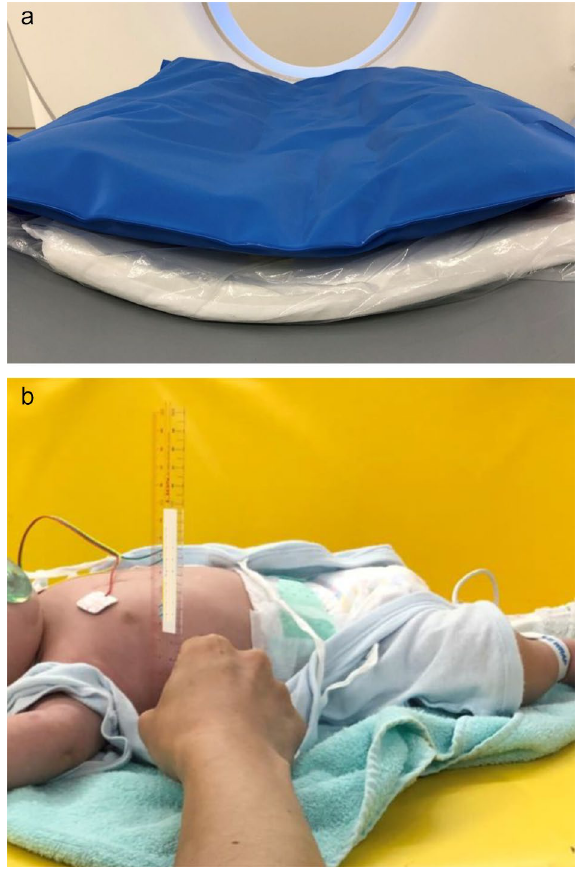
Figure 1. ( a ) The high-resilience pad (white mattress) is put under the vacuum device (blue mat). The total thickness of the pad system was measured at 75 mm from the top plate, which is restricted to move up to 100 mm below the isocenter of the gantry. ( b ) The chest thickness in the supine position was measured at the level of the nipple by a ruler. In the calculated group, the setting table height was calculated using the following formula; setting table height = 75 + measured chest thickness